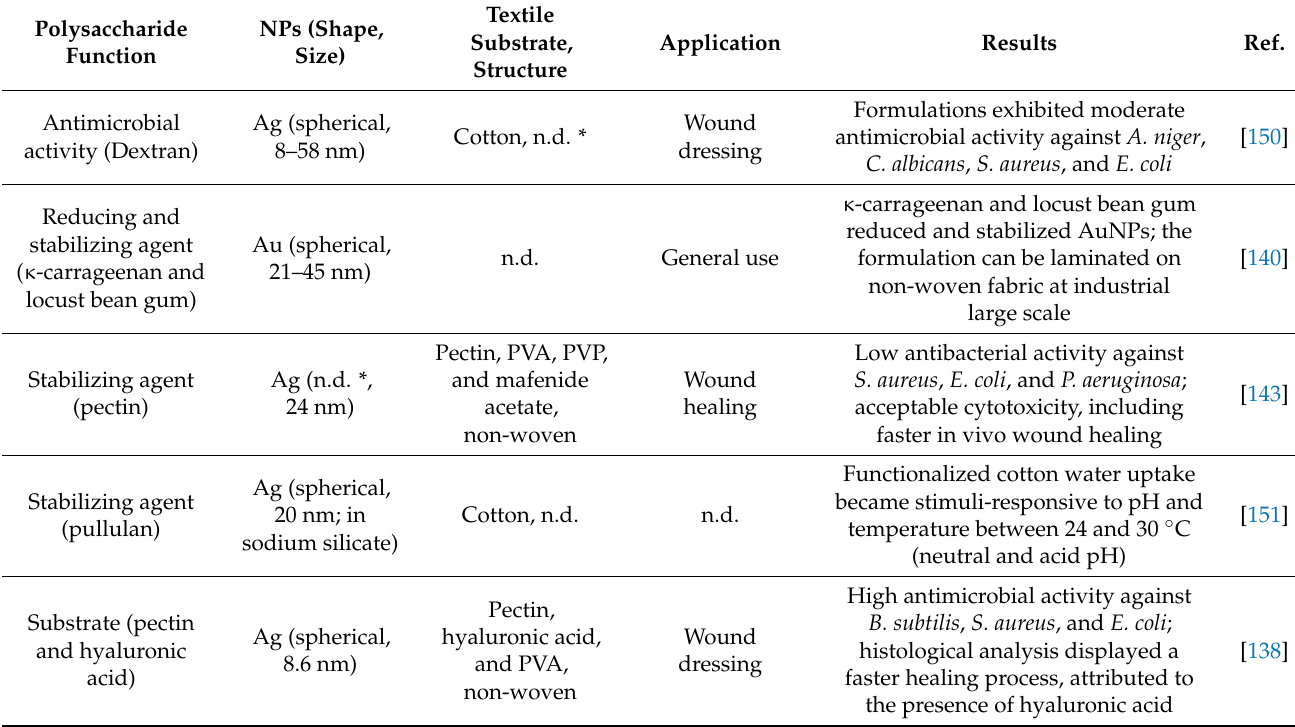
Table 6. Textile materials functionalized with other polysaccharides and metal nanoparticles. Polysac- charide function towards